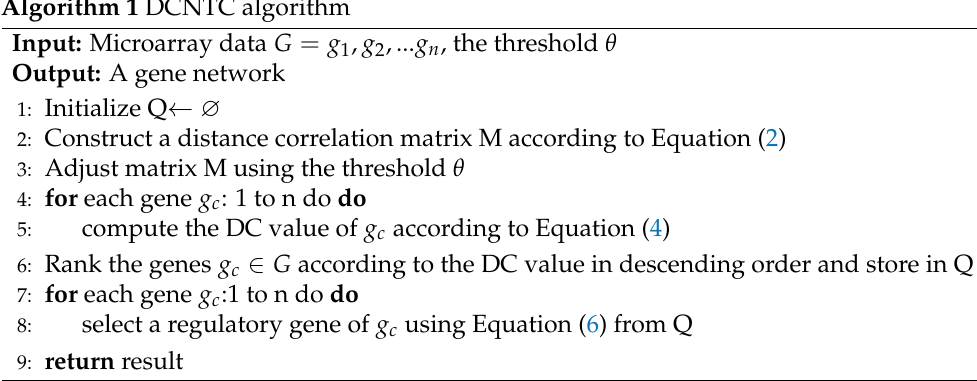
Algorithm 1 DCNTC